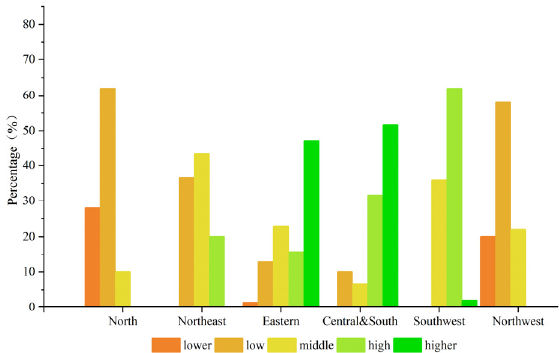
Figure 7. Distribution of cooperative security grades in different regions.